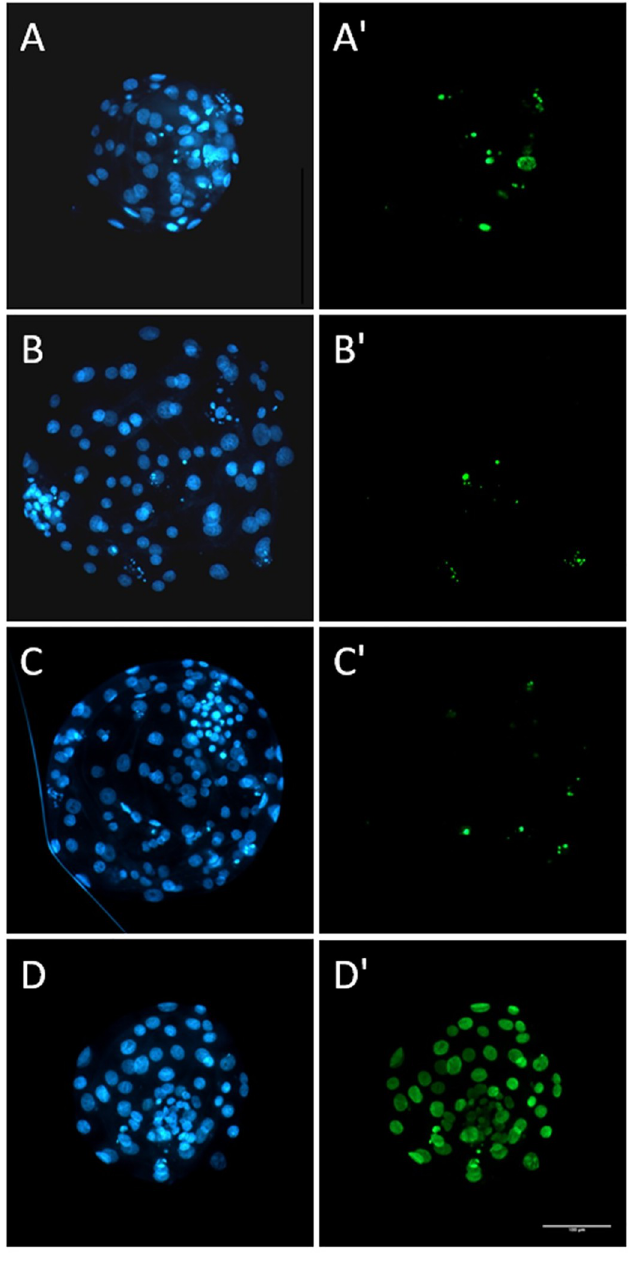
Fig 5. Fluorescent images of total nuclei (blue, A-D) and TUNEL positive nuclei (green, A’-D’) in blastocysts on Day 7. A-A’: a representative embryo obtained without vitrification; B-B’: a representative embryo obtained from a vitrified GV-stage oocyte; C-C’: a representative embryo obtained from a vitrified zygote; D-D’: a representative embryo processed after DNase treatment (positive control). The scale bare represents 100 μ m.